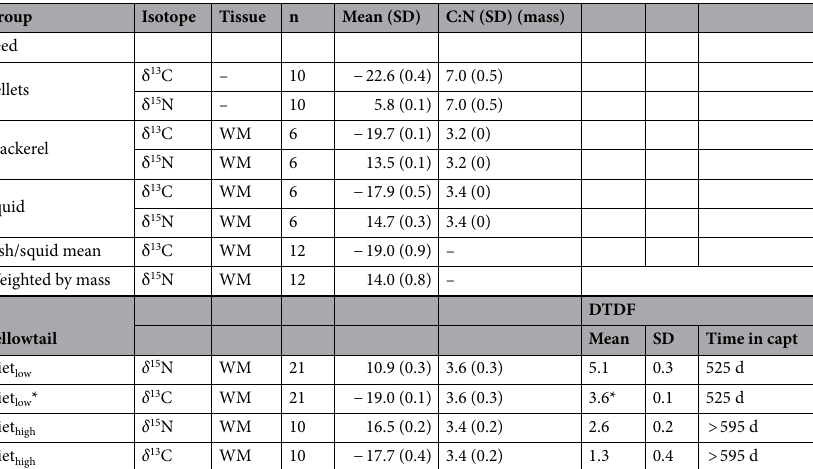
Table 1. Mean δ 15 N, δ 13 C, and C:N ratio values of California yellowtail ( Seriola dorsalis ) muscle tissue, captive feed, and calculated diet-specific DTDF values for pellet and fish/squid diet. δ 13 C values are arithmetically lipid-corrected according to Logan et al. 55 . *The δ 13 C values of Diet low (pellet diet) could not be corrected for carbonate and or lipid due to unknown pellet composition; this DTDF is based on bulk pellet δ 13 C